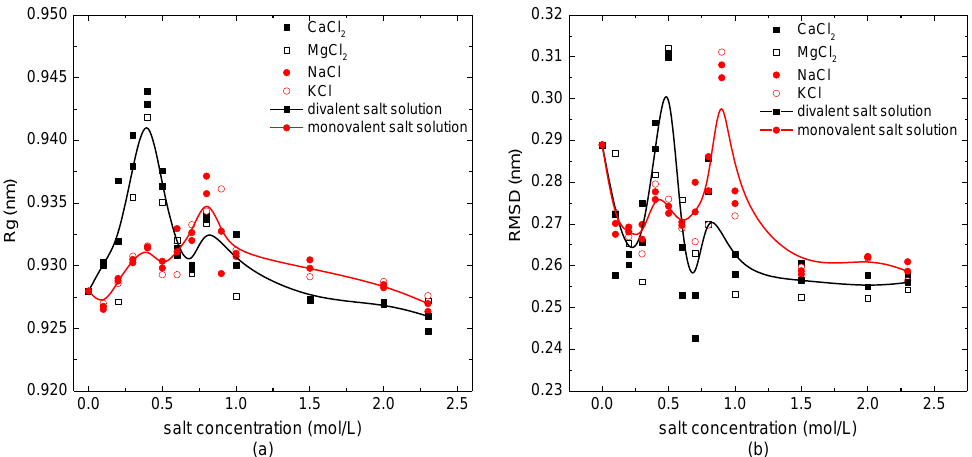
Figure 2. The structural parameters of the protein system versus the external salt concentration. ( a ) The radius of gyration and ( b ) the root mean square deviation.